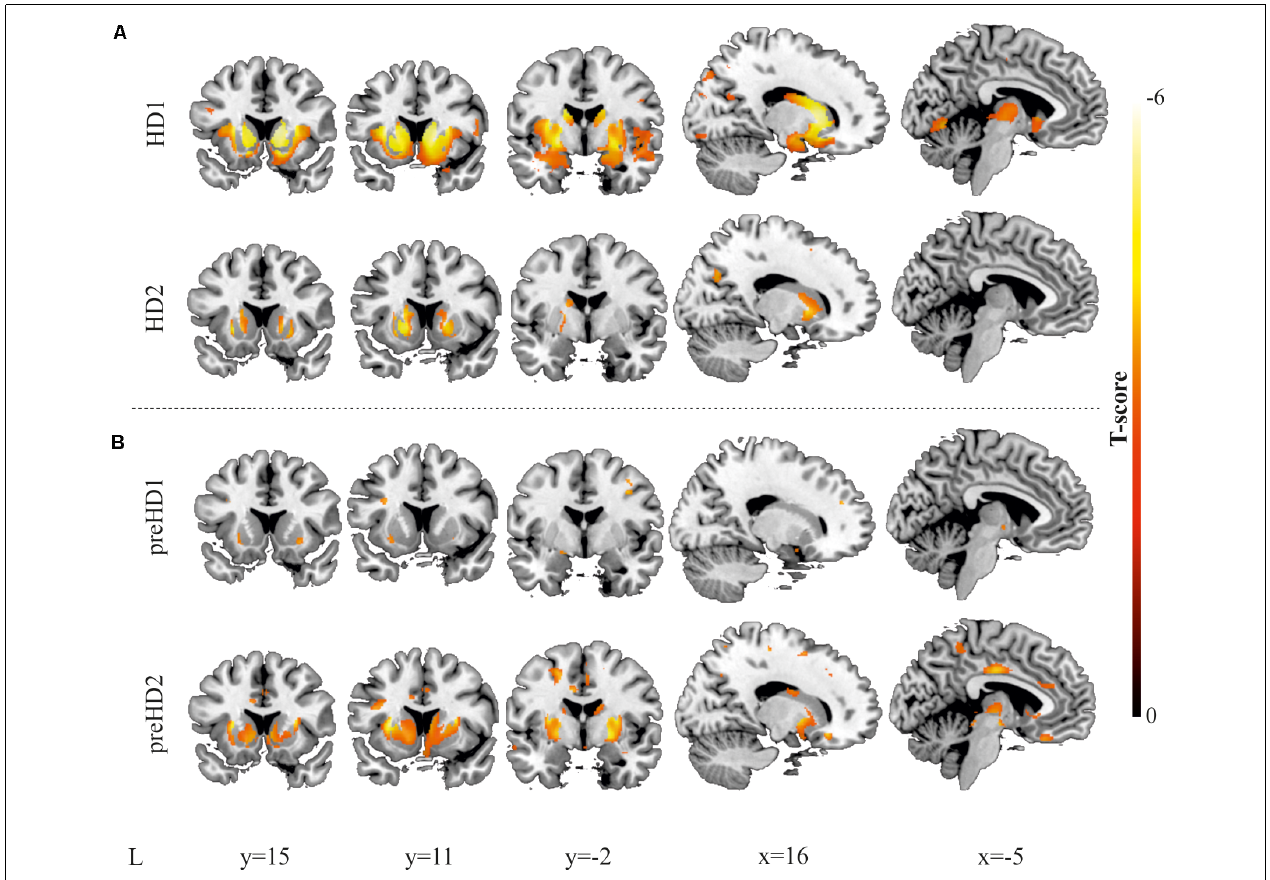
FIGURE 7 | Results derived from the VBM. Decreases in GM are displayed for two individuals with manifest HD (A) and two individuals with pre-manifest HD (B) . All images are displayed with a significance threshold of P < 0.005 (uncorrected). T-scores are indicated by color temperature. The numbers below panels indicate MNI